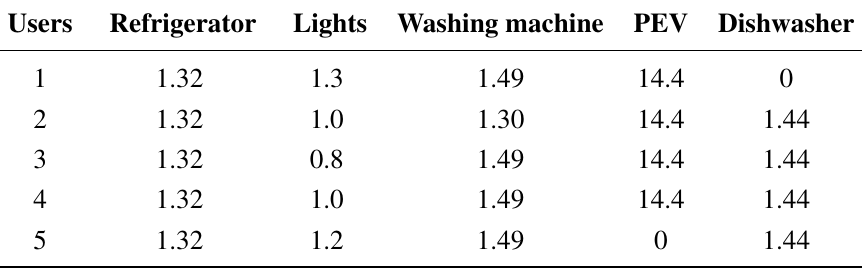
Table 1. Daily electricity consumption of each residential load (kW (cid:1)